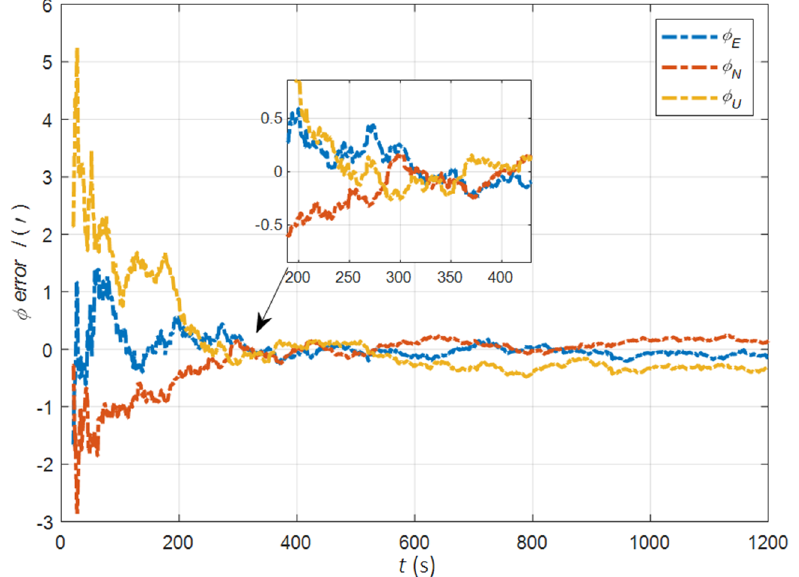
φ ° ° ° . Figure 10. The error curves of φ in the cases of the initial misalignment angles [ 0.2 ◦ 0.2 ◦ 2 ◦ ] T . Figure 10. The error curves of in the cases of the initial misalignment angles T [0.2 0.2 2 ] The data in Table 3 are the RMSE values of φ in 200–1200 s under two initial misalign- ment angles. As can be seen from the above figures and tables, the estimated errors of the triaxial misalignment angle have converged rapidly since 200 s. In the cases of the initial misalignment angles [ 0.2 ◦ 0.2 ◦ 2 ◦ ] T , the estimation accuracy of the horizontal misalignment angle is better than 0.2 (cid:48) , and that of the azimuth misalignment angle is better than 0.3 (cid:48) . In the cases of the initial misalignment angles [ 5 ◦ 5 ◦ 20 ◦ ] T , the estimated accuracy of φ E